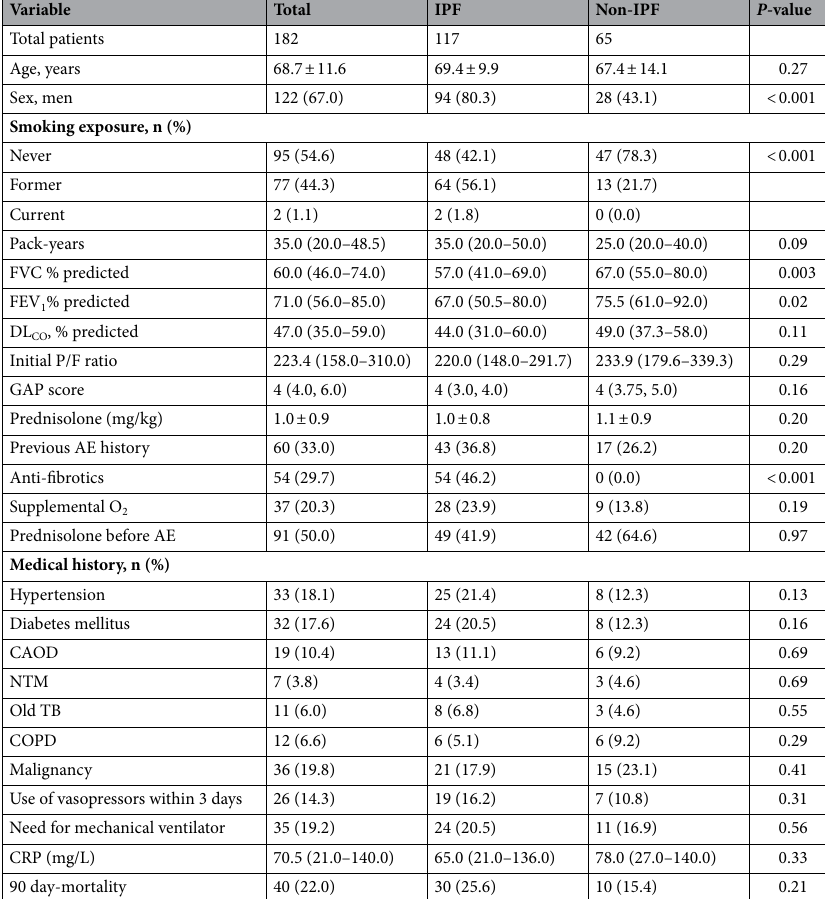
Table 1. Baseline characteristics of patients with acute exacerbation of IPF and non-IPF ILD. Data are presented as mean and standard deviation, median and interquartile range, or frequency (%). IPF idiopathic pulmonary fibrosis, ILD interstitial lung disease, FVC forced vital capacity, FEV 1 forced expiratory volume in 1 s, DLco diffusing capacity of carbon monoxide, P/F ratio partial pressure of oxygen in arterial blood (PaO 2 )/ fraction of inspired oxygen (FiO 2 ) ratio, GAP score system gender (G), age (A), physiology (P), AE acute exacerbation, CAOD coronary artery occlusive disease, NTM non-tuberculous mycobacterium, COPD chronic obstructive lung disease, Old TB previous tuberculosis, CRP C-reactive